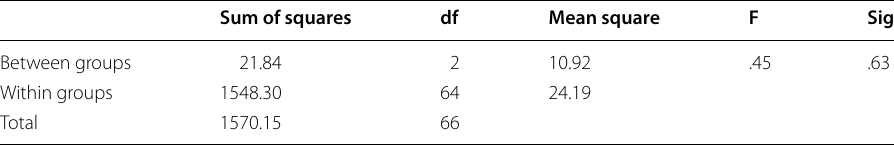
Table 4 One-way ANOVA of TST, pretest Sum of squares df Mean square F Sig. Between Groups 25.94 12.97 .56 .56 Within Groups 1459.69 22.80 Total 1485.64 66